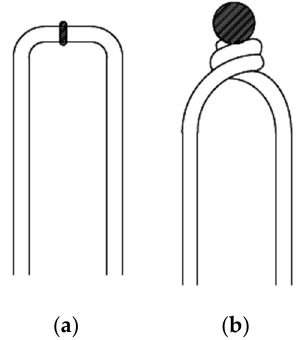
Figure 1. Two types of filamentous thermocouple: ( a ) butt-welded and ( b ) ball-welded.